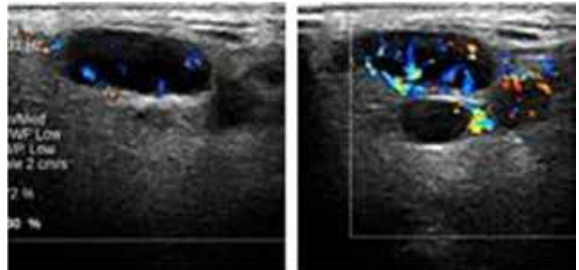
Figure 1 Type I lymph node of Kimura disease in right parotid gland.